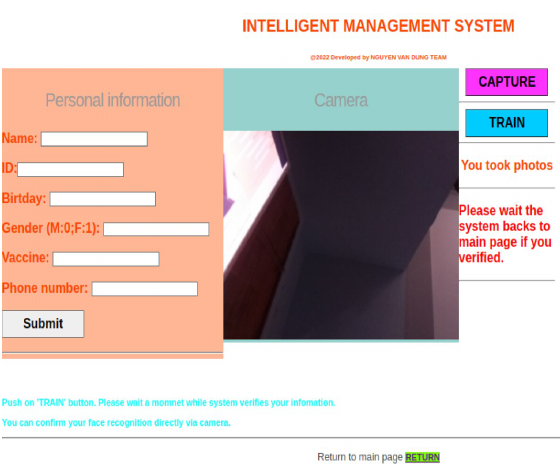
Figure 15. Display of the search results page.